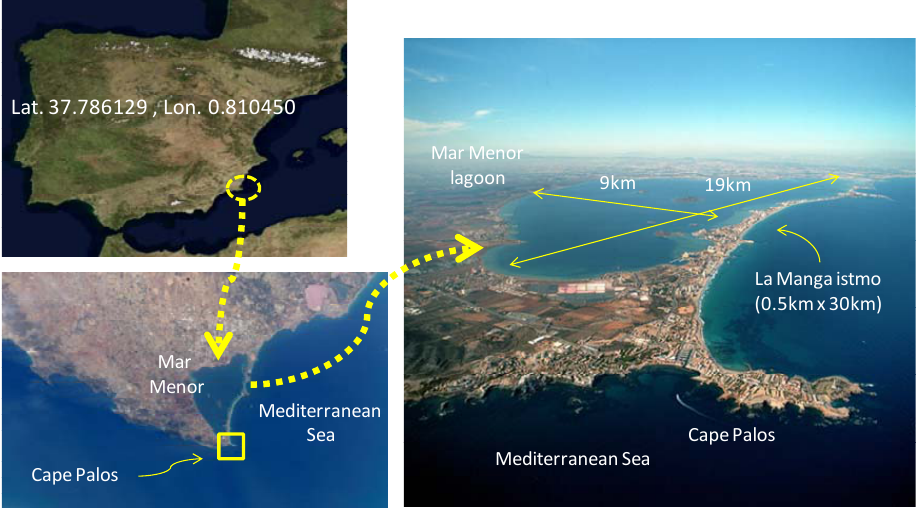
Figure 10. Location of the Mar Menor